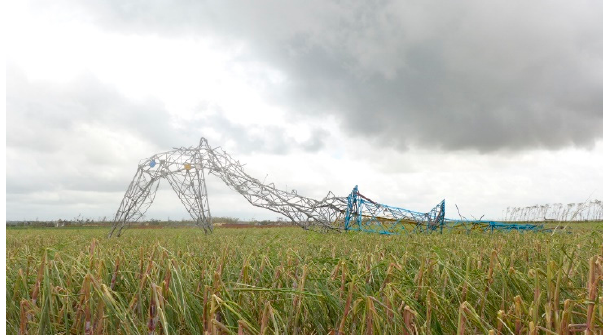
Figure 1. Collapse of a transmission tower in China caused by wind loading.